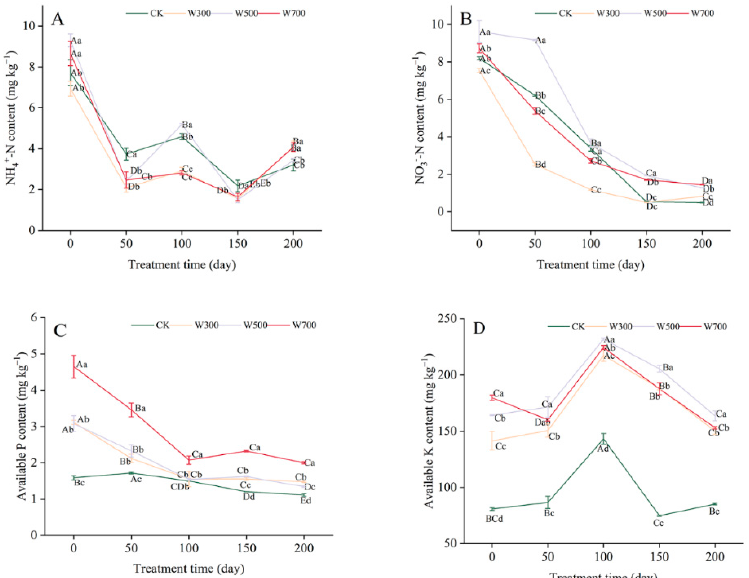
Figure 4. Effects of biochar pyrolyzed at different temperatures on soil available contents of NH 4+ -N ( A ), NO 3 − -N ( B ), available P ( C ), and available K ( D ) at 0, 50, 100, 150 and 200 days of treatment. CK: without biochar; W300: with biochar pyrolyzed at 300 ◦ C; W500: with biochar pyrolyzed at 500 ◦ C; W700: with biochar pyrolyzed at 700 ◦ C. Different uppercase letters indicate significant differences among the different sampling times in the same treatment, while different lowercase letters indicate significant differences among different treatments at the same sampling time according to Duncan’s test ( p < 0.05), respectively.